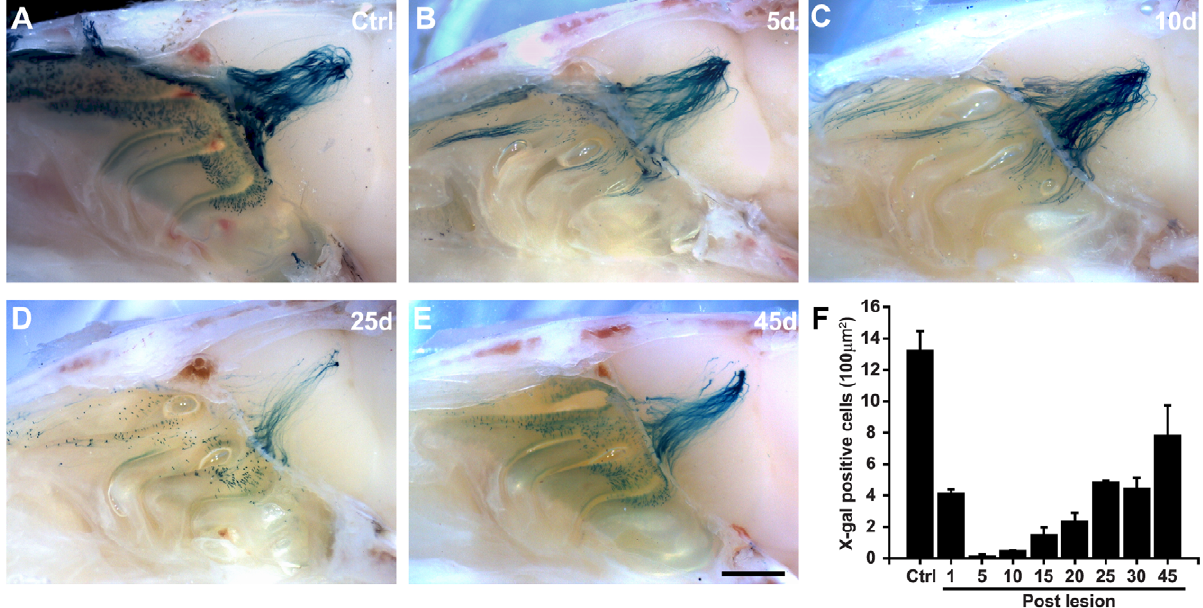
Figure 1. M72 olfactory circuit is restored following ablation by methimazole administration. A , Medial view of OE and OB is shown. M72 neurons lie at the dorsal portion of the turbinates, their axons innervate the dorsal aspect of OB were they coalesce into glomeruli. B , No cell bodies can be observed 5 days post lesion. C , Ten days after lesion few M72-positive neurons are observed. X-gal stained axons and glomeruli remained visible on the surface of the bulb. D , 25 days post lesion M72-positive neurons could be observed in the turbinates and their axons have re- innervated the OB. E , After 45 days, M72-positive cell bodies and glomeruli have regenerated almost completely. The pattern of innervation is similar to control animals even though some wandering axons remain visible. F , Cell counts at the turbinates show the time-course of regeneration of X-gal stained cells. Scale bar 500 m m. Mean 6 SEM are represented.